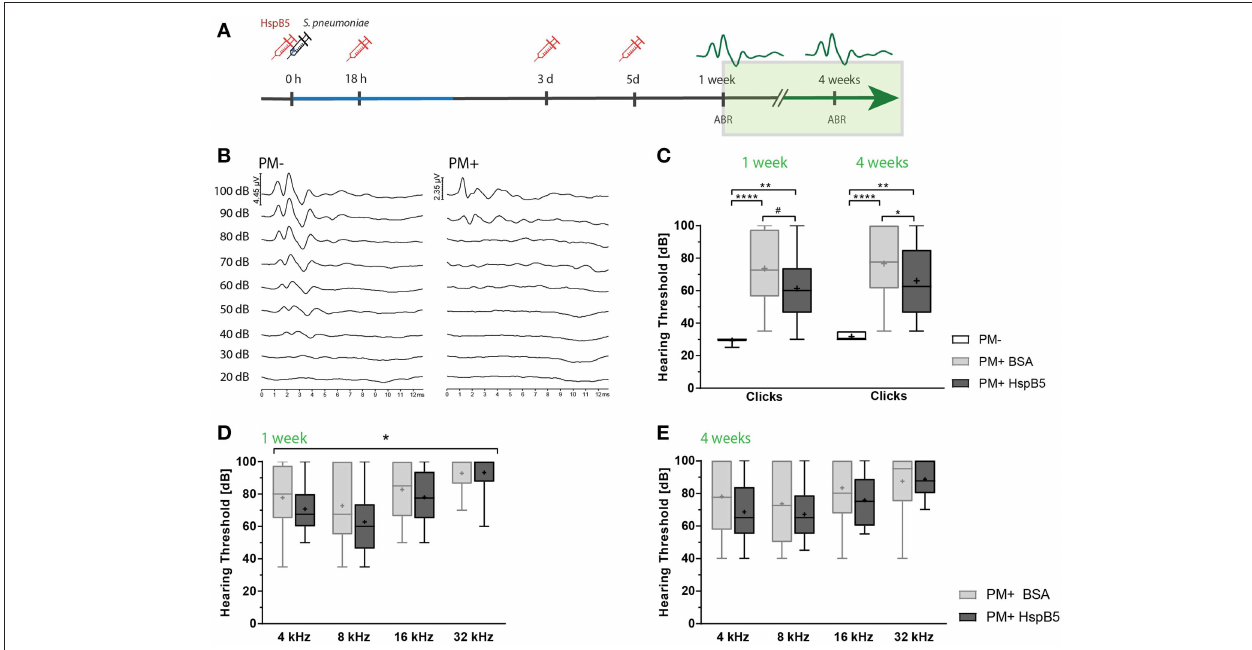
FIGURE 4 | Intracisternal administration of HspB5 results in improved hearing thresholds. (A) Schematic representation of the experimental setup to study late phase outcomes. Intracisternal delivery of HspB5 (red syringe) is performed immediately prior to the infection and at 18hpi, 3 days, and 5 days post infection. (B) Representative example of hearing thresholds of a control animal (PM-: 30 dB, left) and an infected animal (PM + : 90 dB, right). (C) ABR recording using broad band click stimuli 1 and 4 weeks post infection in uninfected ( n = 6 ears of 3 animals) and infected animals [untreated: ( n = 20 ears/10 animals) and HspB5 treated: ( n = 20 ears/10 animals)]. (D) Pure tone ABR thresholds 1 and (E) 4 week post infection for untreated and HspB5 treated animals ( n = 20 ears/10animals per group). Box and whisker plot quartiles from min-max. Statistical differences were assessed by one-way ANOVA with Tukey’s multiple comparison test. # p value for unpaired t -tests p = 0.053 (in C ) and two-way ANOVA (in D,E ). * p < 0.05; ** p < 0.01 **** p <